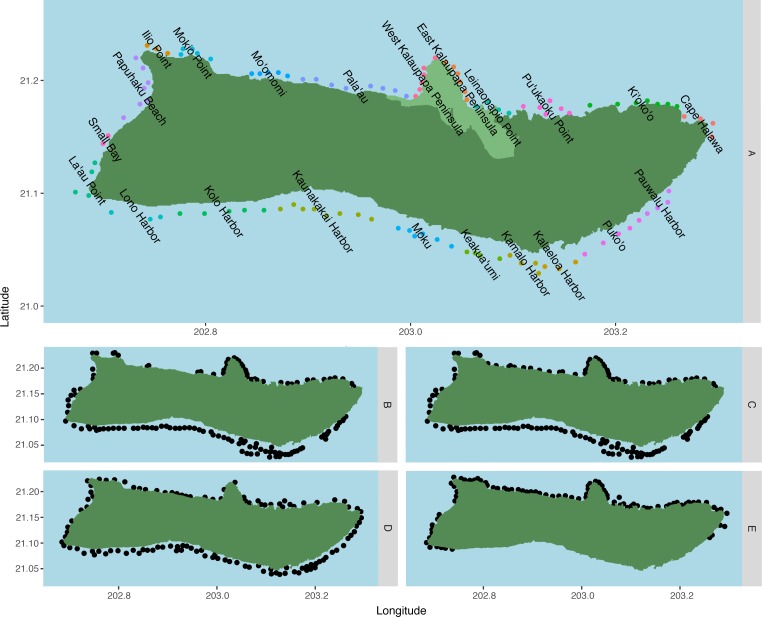
Spawning sites used in the model by species.(A) C. perspicillatus, S. rubroviolaceus, P. porphyreus, C. strigosus, C. ignoblis, and C. melampygus, n = 109; (B) P. meandrina, n = 129;(C) O. cyanea and Panulirus spp., n = 136; (D) P. sexfilis, n = 115; and (E) Cellana spp., n = 87. Region names are displayed over associated spawning sites for fish species in (A). Regions are made up of two to 11 sites, grouped based on coastal geography and surrounding benthic habitat, and are designated in (A) by adjacent colored dots. Kalaupapa National Historical Park is highlighted in light green in (A).